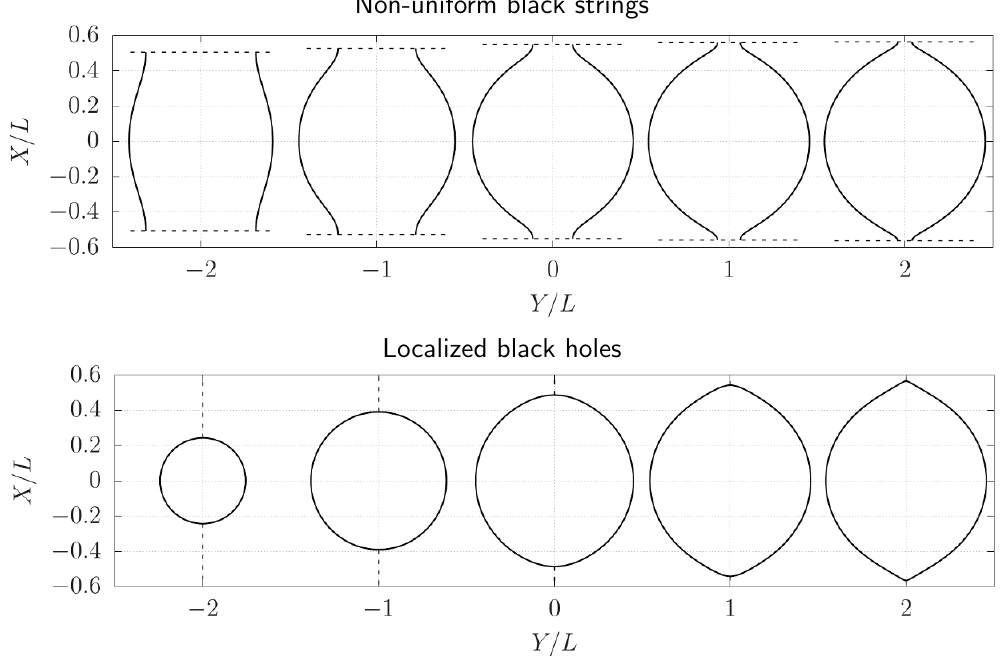
Figure 6 . Embedding of the spatial cross-section of the horizon into Euclidean space for di(cid:11)erent NUBS (top) and LOC (bottom). For NUBS, from left to right, r 0 = 0 : 74328 ( (cid:21) (cid:24) 0 : 1), r 0 = 0 : 77216 ( (cid:21) (cid:24) 0 : 5), r 0 = 0 : 78950 ( (cid:21) (cid:24) 1 : 5), r 0 = 0 : 79156 ( (cid:21) (cid:24) 3) and r 0 = 0 : 79184 ( (cid:21) (cid:24) 5). For LOC the axis is parallel to X=L and represented by a dashed line starting at the poles. From left to right: (cid:20) = 2 : 4 ( (cid:15) (cid:24) 10 (cid:0) 3 ), (cid:20) = 1 : 5 ( (cid:15) (cid:24) 10 (cid:0) 1 ), (cid:20) = 1 : 29 ( (cid:15) (cid:24) 10 0 ), (cid:20) = 1 : 26341 ( (cid:15) (cid:24) 10) and (cid:20) = 1 : 26277 ( (cid:15) (cid:24) 3 (cid:1) 10 2 ). Note that the embeddings look ‘rounder’ or ‘fatter’ compared to the ones in lower dimensions; this is just a manifestation that gravity becomes more localized as D